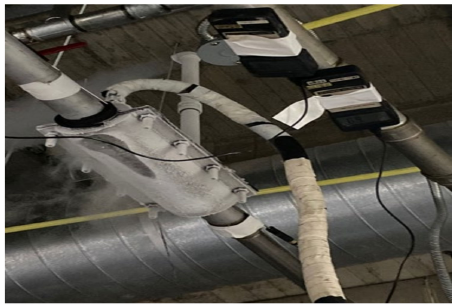
Figure 6. Fast-deployable